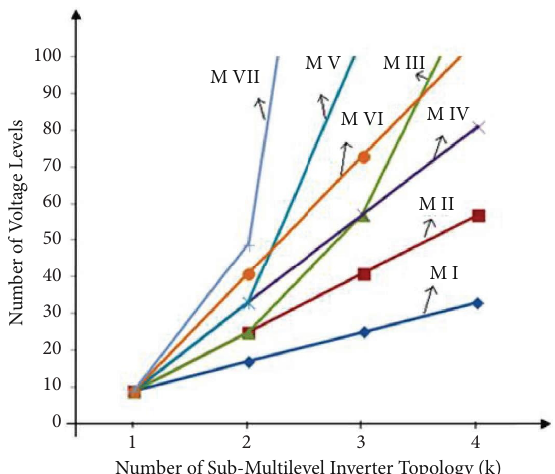
Figure 7: Voltage level variation with proposed submultilevel